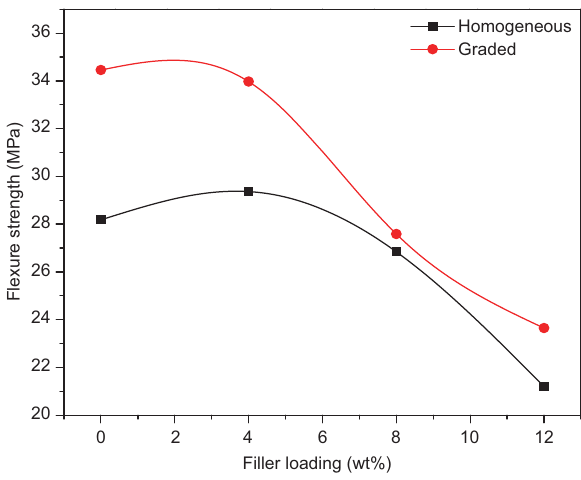
Figure 3 Variation of flexural strength on filler loading of composites.